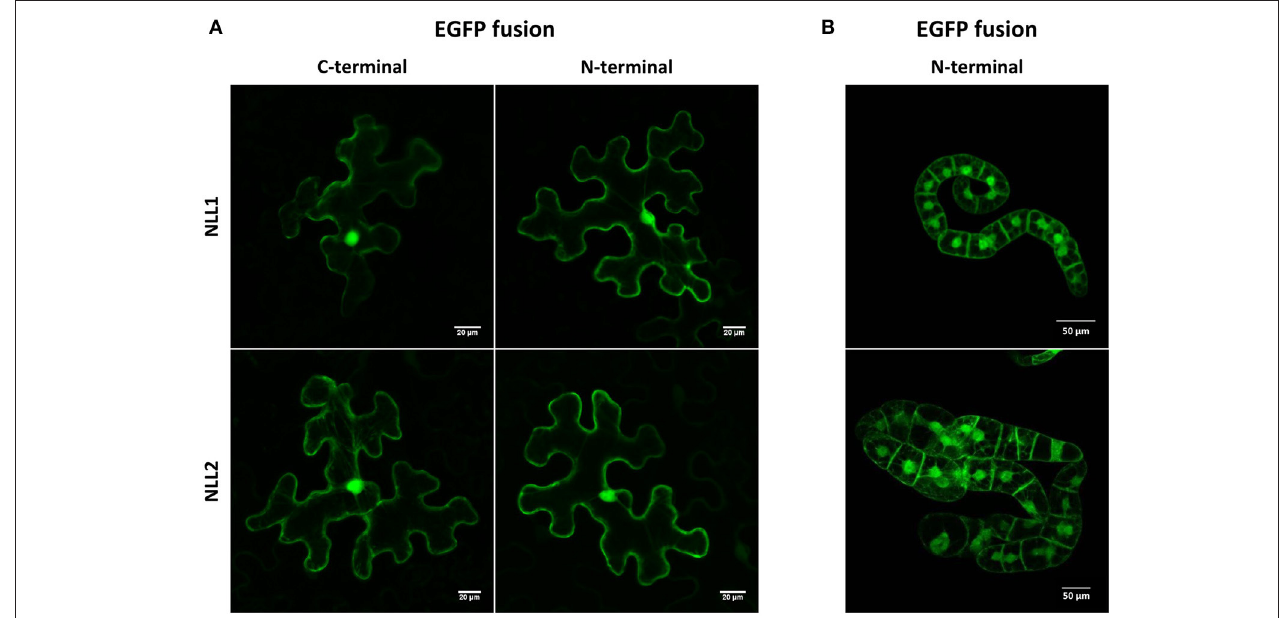
FIGURE 2 | Localization pattern of N- and C-terminal EGFP fusion constructs expressed in (A) transiently transformed N. benthamiana leaves and (B) in stably transformed BY-2 cells.